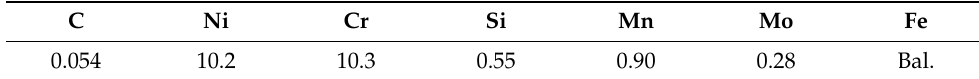
Table 1. Chemical composition of the LTT steel in